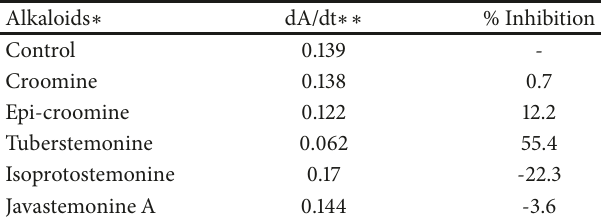
Table 2: Inhibition of diaphorase activity of Pf